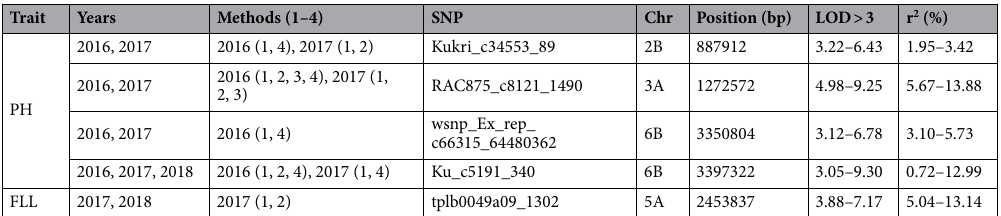
Table 3. Stable SNPs identified simultaneously in different environments and different methods associated with plant height and flag leaf length. Methods (1–4): Corresponding four multi-locus GWAS methods i.e. mrMLM, FASTmrMLM, FASTmrEMMA, and pLARmEB, respectively. r 2 (%) represents proportion of total phenotypic variation explained by each SNP. PH (plant height); FLL (flag leaf length).